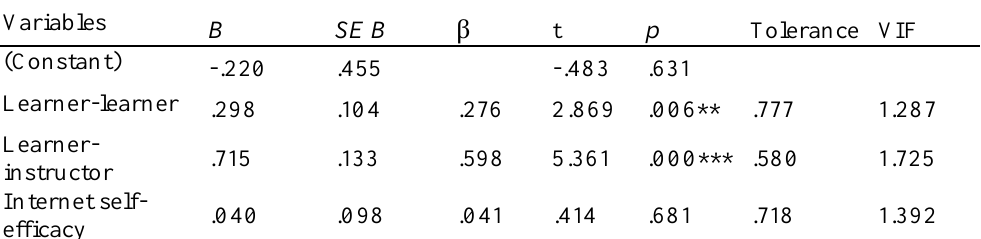
Multiple Regression